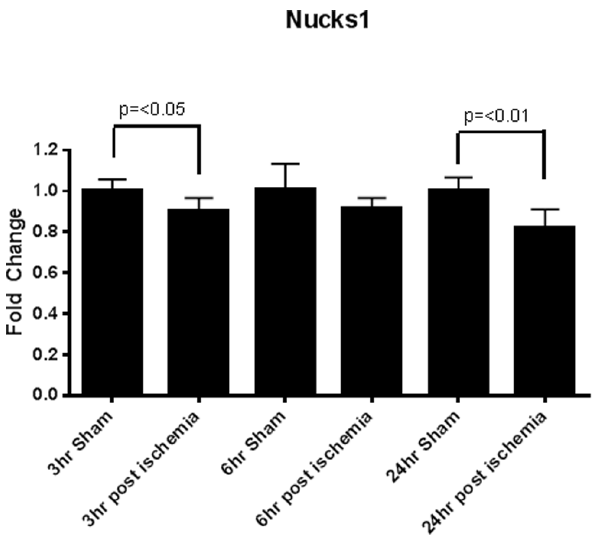
Figure 7. Nucks1 expression in the kidneys of mice with renal ischemia-reperfusion. Nucks1 gene expression was down-regulated in the injured kidneys at all time points and reached significance at 3 and 24 hours after